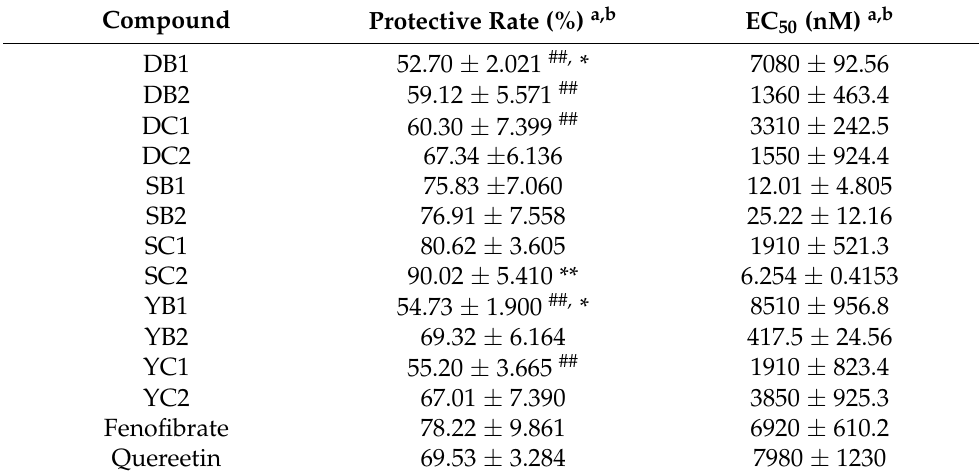
Table 4. Protective rate of target